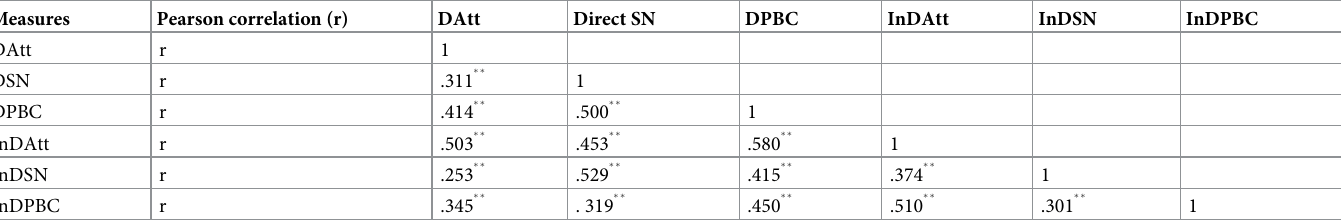
�� Correlation is significant at the 0.01 level (2-tailed).